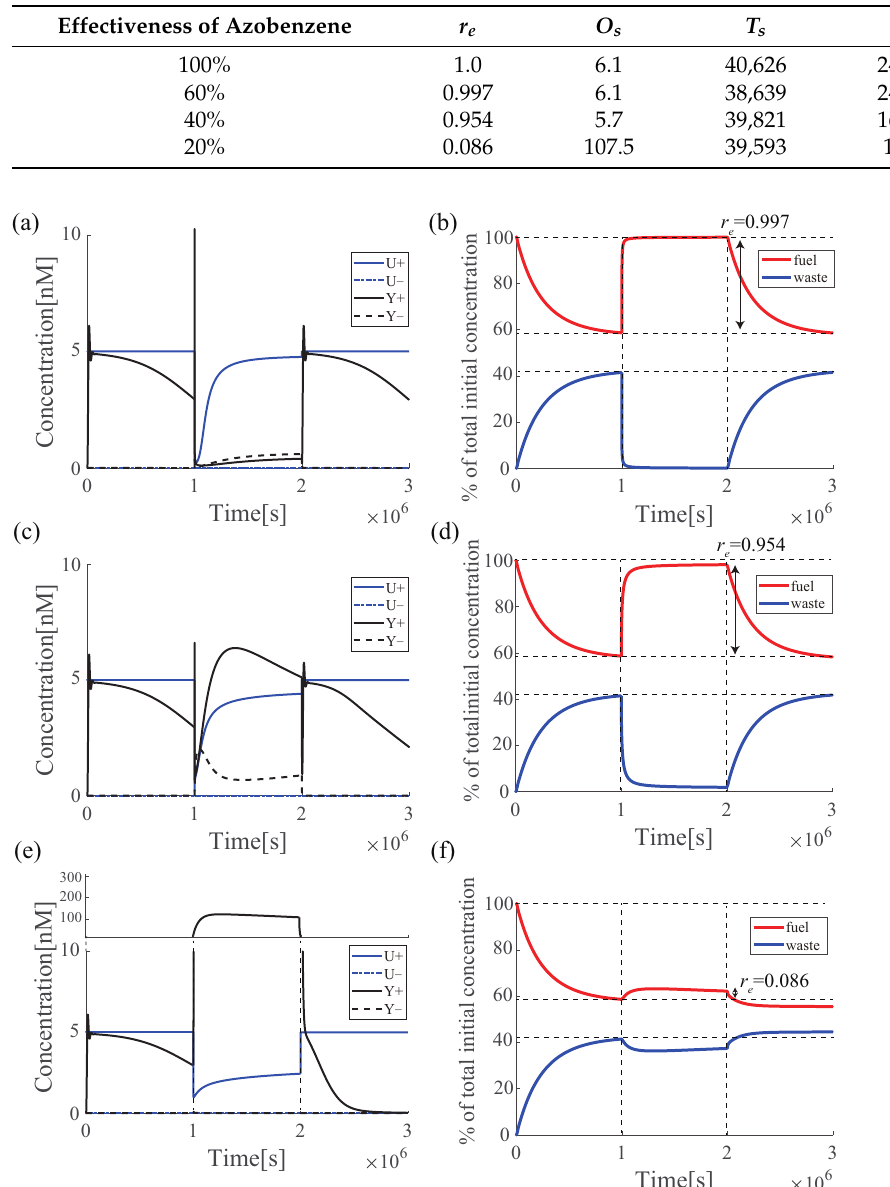
Table 3. Renewable indicators for performance of PI controller and fuel DNA.